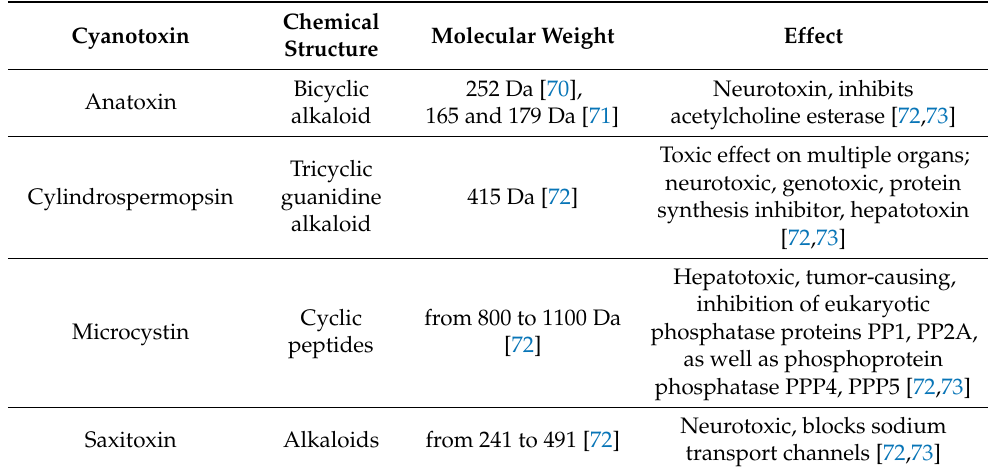
Table 5. Cyanotoxins, their chemical structures, molecular weights, effects, and producers.